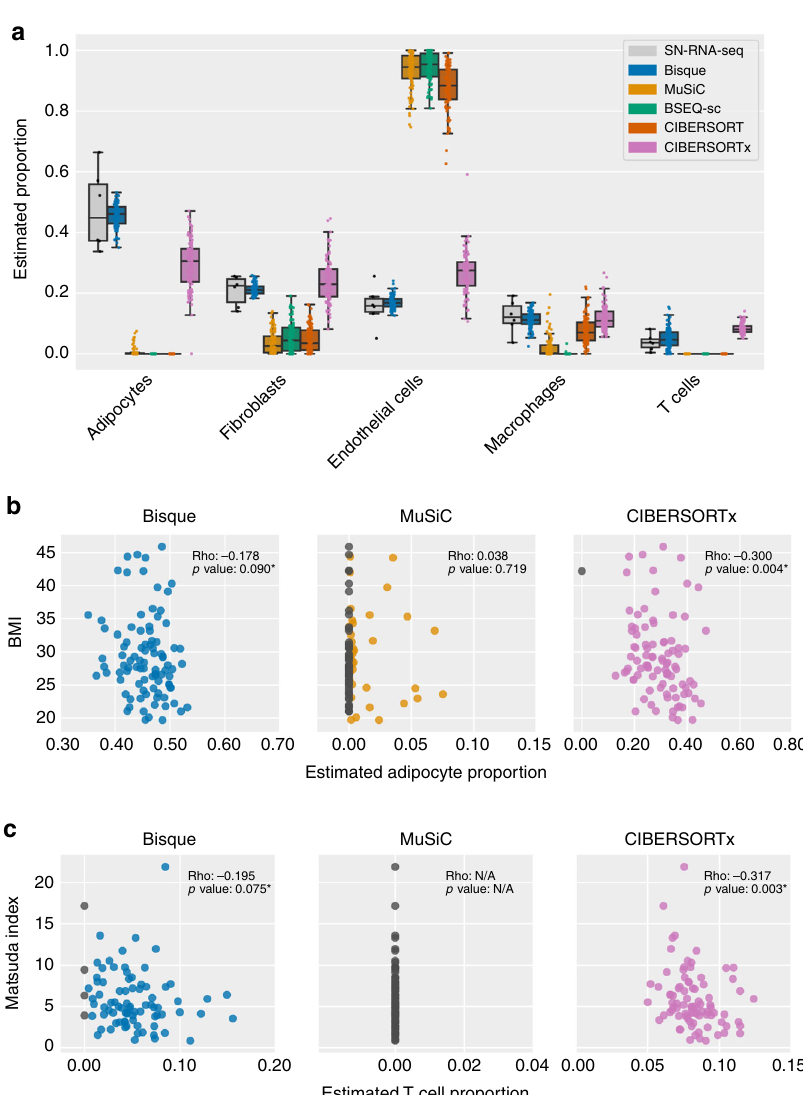
Fig. 3 Decomposition benchmark in human subcutaneous adipose tissue. a Comparison of decomposition estimates from 100 individuals with estimates from 6 individuals with snRNA-seq data available. Each color represents a benchmarked method. Boxes indicate the quartiles of the estimated proportions with whiskers extending 1.5 times the interquartile range. Points are individual samples that are represented by the boxplot. b , c Scatterplots comparing decomposition estimates with measured phenotypes in 100 individuals. Reported ‘ rho ’ corresponds to Spearman correlation and p -values indicate the signi fi cance of these correlations, with an asterisk denoting signi fi cance after correction for covariates in a linear-mixed model. CIBERSORT and BSEQ-sc are not shown as they did not detect these cell populations. These examples include the most abundant (adipocytes) and rarest (T cells) cell types identi fi ed in the snRNA-seq data. Signi fi cance of associations reported in Supplementary Table 1. b Adipocyte proportion has been observed to negatively correlate with BMI so we expected a negative correlation. Bisque ( p = 0.030) and CIBERSORTx ( p = 0.001) produced signi fi cant negative associations after correcting for sex, age, age-squared, and relatedness in a linear-mixed model. c T-cell proportion has previously been reported to positively correlate with insulin resistance. Matsuda index decreases with higher insulin resistance so we expected a negative correlation. Bisque ( p = 0.002) and CIBERSORTx ( p = 0.046) produced signi fi cant negative associations after correcting for diabetes status, sex, age, age-squared, and relatedness in a linear-mixed model. Source data are provided as a Source Data fi